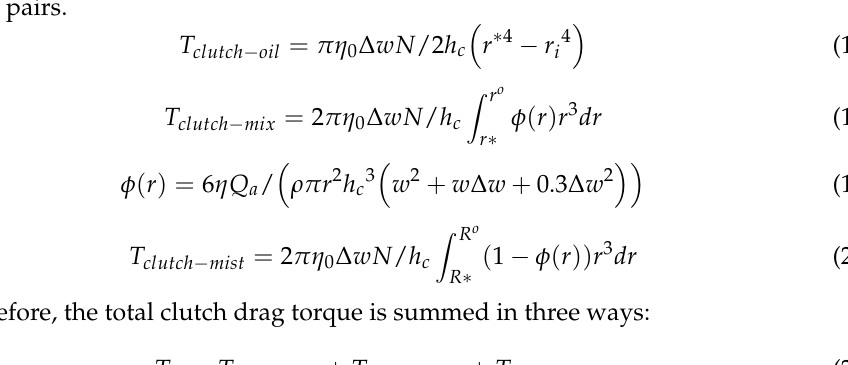
Figure 5. Schematic diagram of the lubrication state between clutch discs. Figure 5: Schematic diagram of the lubrication state between clutch discs 251 According to the oil film state of lubricating oil, the mixed state of oil film and oil mist Figure 5: Schematic diagram of the lubrication state between clutch discs 251 According to the oil film state of lubricating oil, the mixed state of oil film and oil 252 and the pure oil mist state in the friction disc gap, the towed torque T clutch − oil , T clutch − mix mist and the pure oil mist state in the friction disc gap, the towed torque 𝑇 (cid:3030)(cid:3039)(cid:3048)(cid:3047)(cid:3030)(cid:3035)(cid:2879)(cid:3042)(cid:3036)(cid:3039) , 253 According to the oil film state of lubricating oil, the mixed state of oil film and oil 252 and T clutch − mist can be calculated by Equations (17)–(20) respectively, where N is the number 𝑇 𝑇 (cid:3030)(cid:3039)(cid:3048)(cid:3047)(cid:3030)(cid:3035)(cid:2879)(cid:3040)(cid:3036)(cid:3051) and (cid:3030)(cid:3039)(cid:3048)(cid:3047)(cid:3030)(cid:3035)(cid:2879)(cid:3040)(cid:3036)(cid:3046)(cid:3047) can be calculated by Eqs. (17-20) respectively, where N is the 254 mist and the pure oil mist state in the friction disc gap, the towed torque 𝑇 (cid:3030)(cid:3039)(cid:3048)(cid:3047)(cid:3030)(cid:3035)(cid:2879)(cid:3042)(cid:3036)(cid:3039) , 253 of friction pairs. number of friction pairs. 𝑇 𝑇 (cid:3030)(cid:3039)(cid:3048)(cid:3047)(cid:3030)(cid:3035)(cid:2879)(cid:3040)(cid:3036)(cid:3051) and (cid:3030)(cid:3039)(cid:3048)(cid:3047)(cid:3030)(cid:3035)(cid:2879)(cid:3040)(cid:3036)(cid:3046)(cid:3047) can be calculated by Eqs. (17-20) respectively, where N is the 254 number of friction pairs.